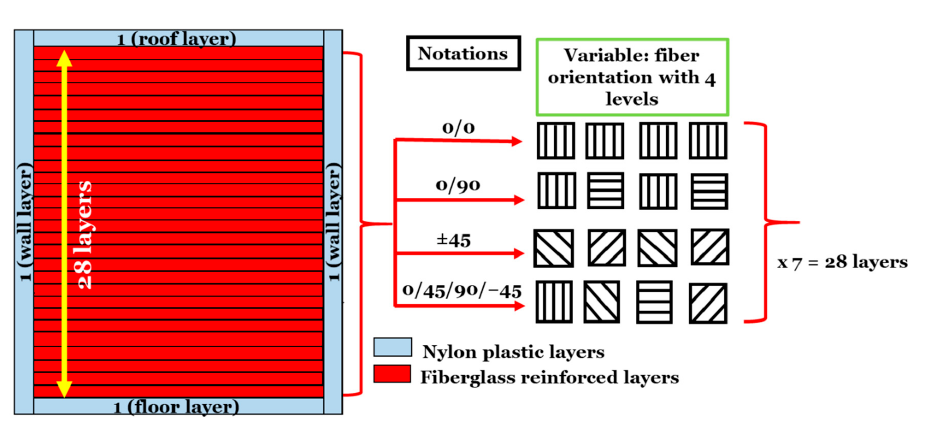
Figure 1. Experimental design. Table 1. Weight and fiber volume fraction of the composites.